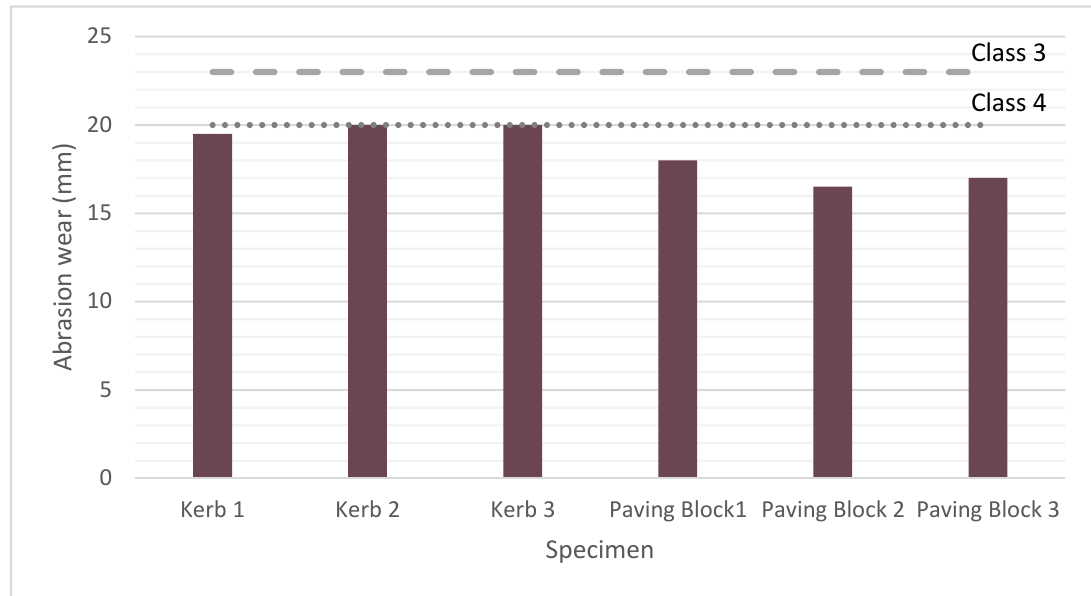
Figure 6. Abrasion resistance test findings for six RACC specimens (three kerbs and three paving blocks) and maxima specified in the respective standards, EN 1340 [46,47] and 1338 [42,43] .